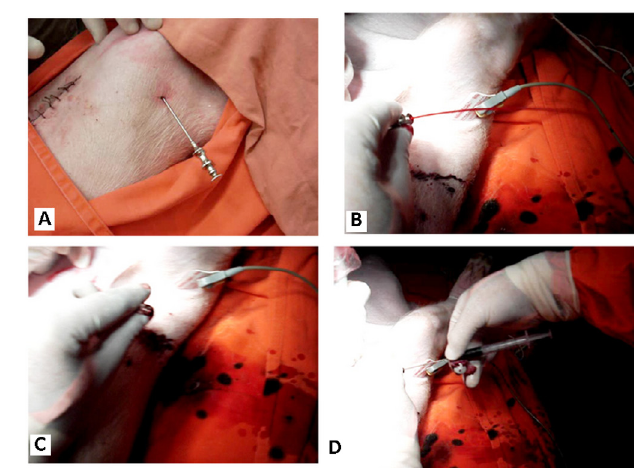
Fig. 3 - Percutaneous puncture technique. A - The percutaneous needle is introduced at a point 1 to 2 cm away from the apex of the heart; B - it reaches the left ventricular cavity (pulsed blood jetting); C - A slight and slow retreat of the needle until the blood jetting stops means that the muscular wall of the left ventricular myocardium completely occluded the holes; and D - The operator introduces the mandrel with bristles for scraping so as to create microlesions.